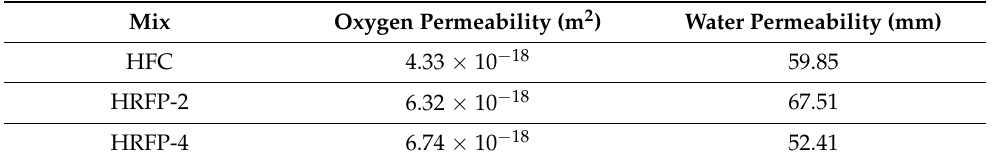
Table 7. Concrete permeability results.